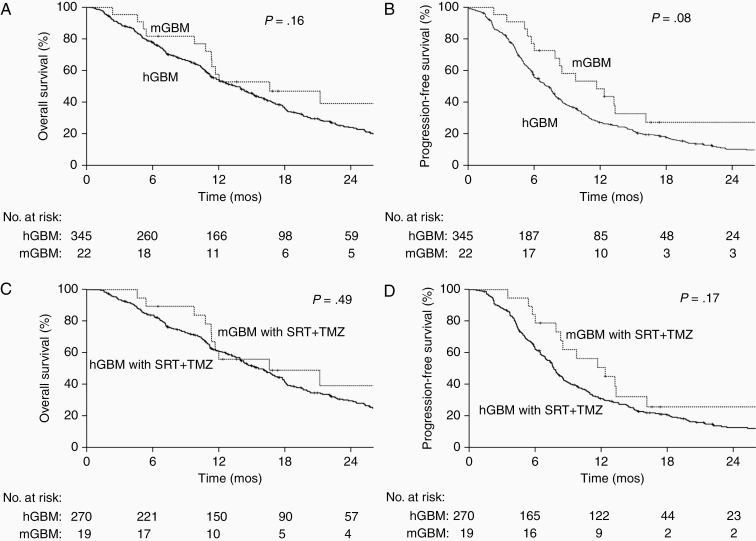
Survival outcomes of patients stratified by molecular glioblastoma (mGBM) and histological GBM (hGBM) status. (A) Overall survival (OS) of the entire study cohort. (B) Progression-free survival (PFS) of the entire study cohort. (C) OS of the subset receiving standard-course radiation therapy (SRT) and temozolomide (TMZ). (D) PFS of the subset receiving SRT and TMZ.